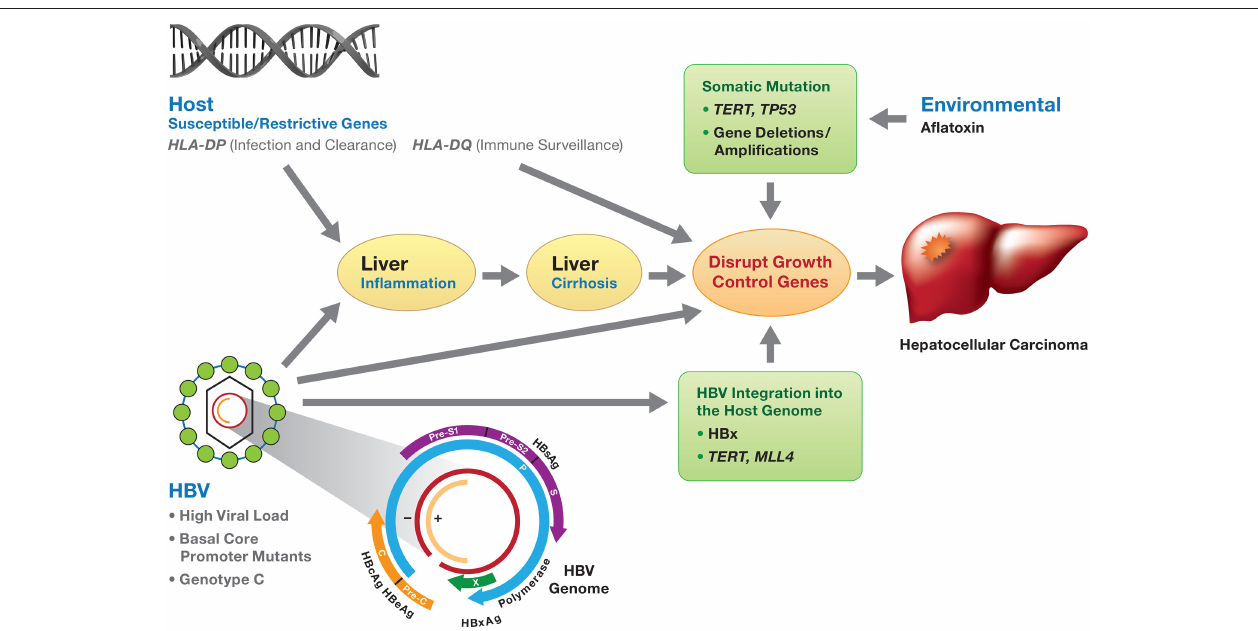
FIGURE 1 | Viral and host genetic factors involved in the development of HBV-induced HCC. HBV infection, if not resolved, may develop to chronic hepatitis and progress to liver cirrhosis and subsequently HCC. Molecular mechanisms of HBV-related HCC involve (1) chronic inflammation and regeneration of hepatocytes; (2) accumulation of genetic alterations that confer cell growth advantage; (3) integration of HBV DNA into the host genome and activation of host genes controlling cell proliferation; (4) genomic instability; and (5) direct promotion of cell proliferation by viral proteins (mainly HBx). The development of HCC is the consequence of the interaction of environmental factors (e.g., aflatoxin), HBV viral factors (genotypes, HBV DNA levels and HBV mutants) and host genetic susceptible variants (e.g., HLA-DP variants affecting HBV clearance), along with somatic mutations ( TP53 , TERT , gene deletion/amplification) disrupting cell growth control. HBV genotype C and mutations in the preS, basic core promoter or HBx gene are associated with an increased risk of HCC.